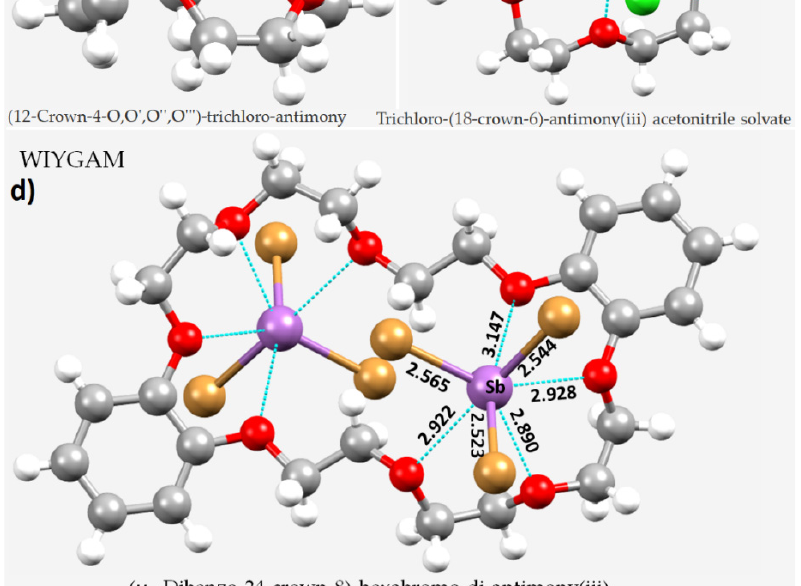
Figure 25. The local structure the crystals of ( a ) (dibenzo-24-crown-8)(SbCl 3 ) 2 ; [160] ( b ) (12-crown- 4)SbCl 3 ; [162] ( c ) (18-crown-6)SbCl 3 ; [161] and ( d ) (dibenzo-24-crown-8)(SbBr 3 ) 2 . [160] Selected bond distances and bond angles are shown in Å and degree, respectively. Solvent acetonitrile in ( a ) is omitted for clarity. The CSD ref. code in capital letters is shown for each case. Atoms are shown as small spheres and bonds as lines in atom color, whereas the intermolecular interactions are represented by dotted lines in